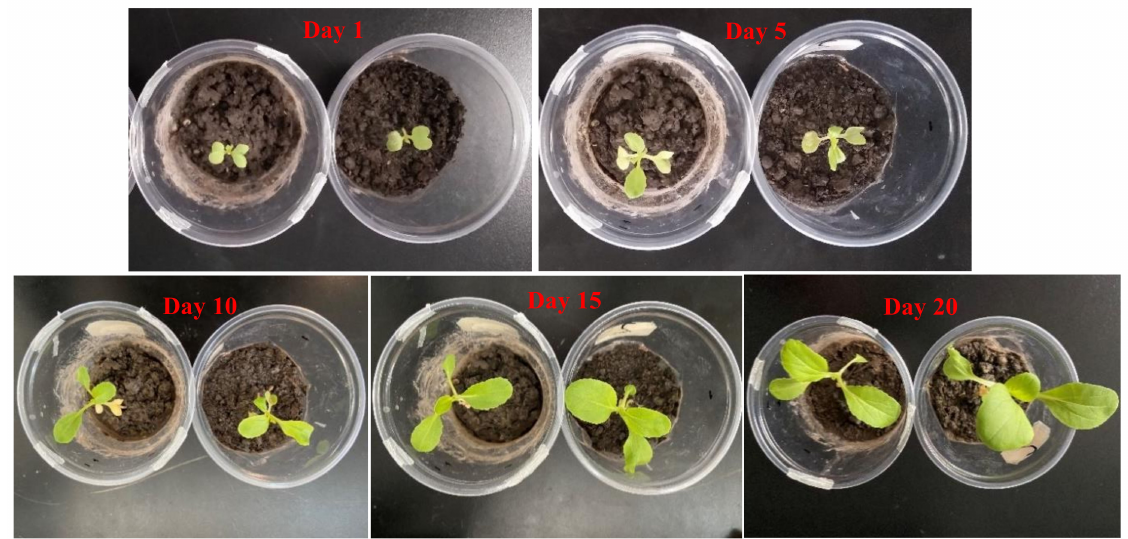
Figure 10. The growth of cabbage seedlings from day 1 to day 20. ( left —CA film, right —CA-Eu film).